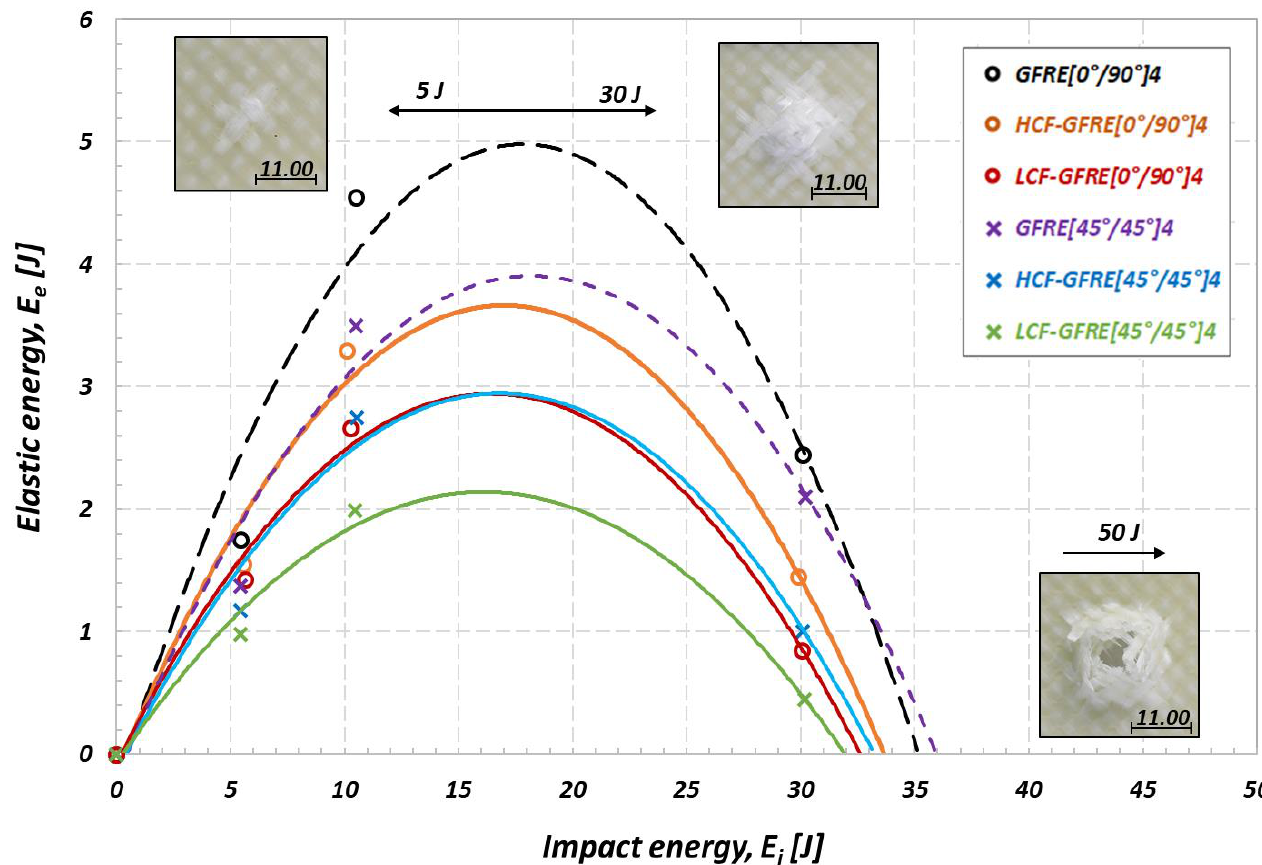
Figure 16. Elastic energy versus impact energy for assessment of the effect of fatigue aging on the penetration threshold of the GFRE at 20 °C.